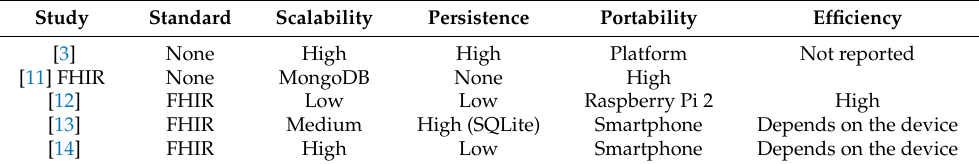
Table 1. Comparison among the state of the art existing solutions focused on IoT and